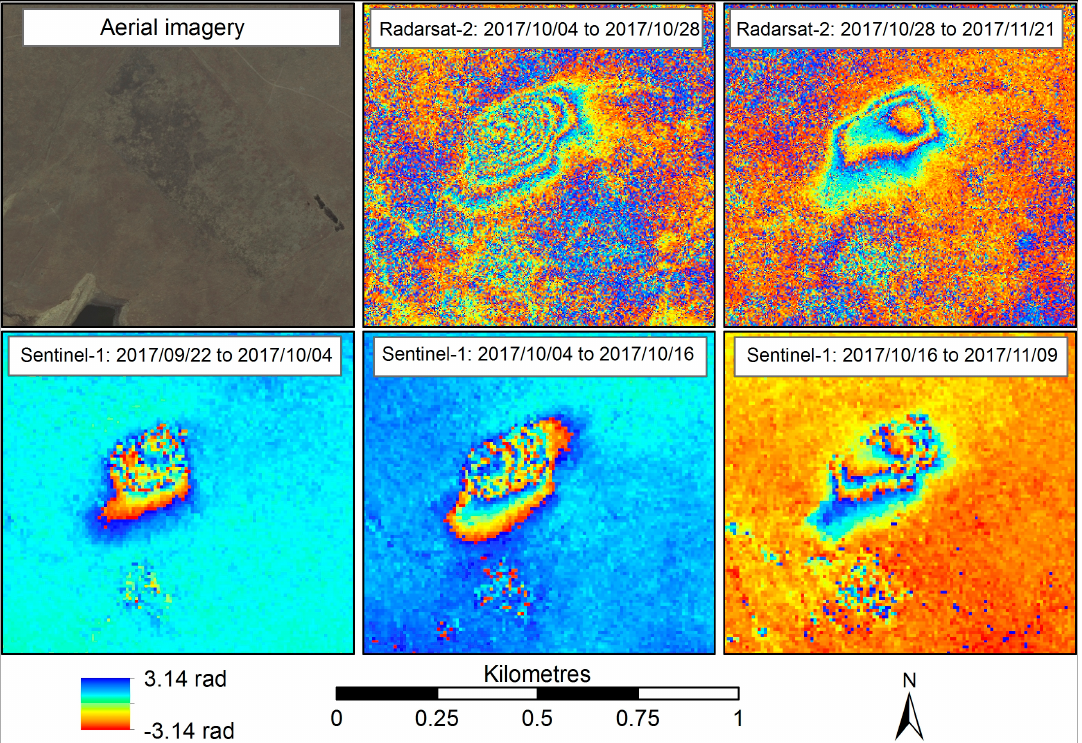
Figure 7. An example of differential interferograms generated from Sentinel-1 data showing ongoing ground deformation related to mining activity in South Africa. Each colour cycle represents ground surface deformation of ~2.7 cm between image acquisitions.